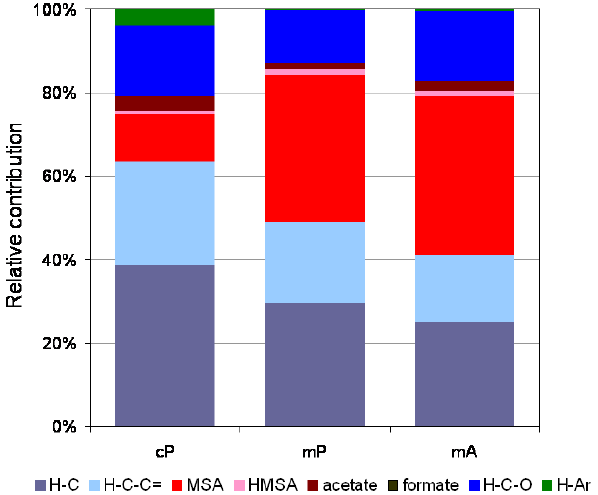
Fig. 12. 1H NMR chemical characterization of WSOC as a func- tion of the air mass